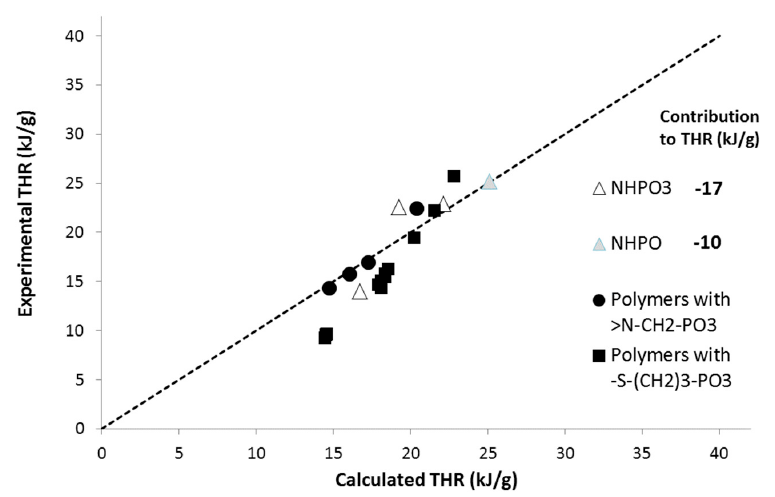
Figure 9. Experimental versus calculated THR for various polymers (from series B, E, and H).